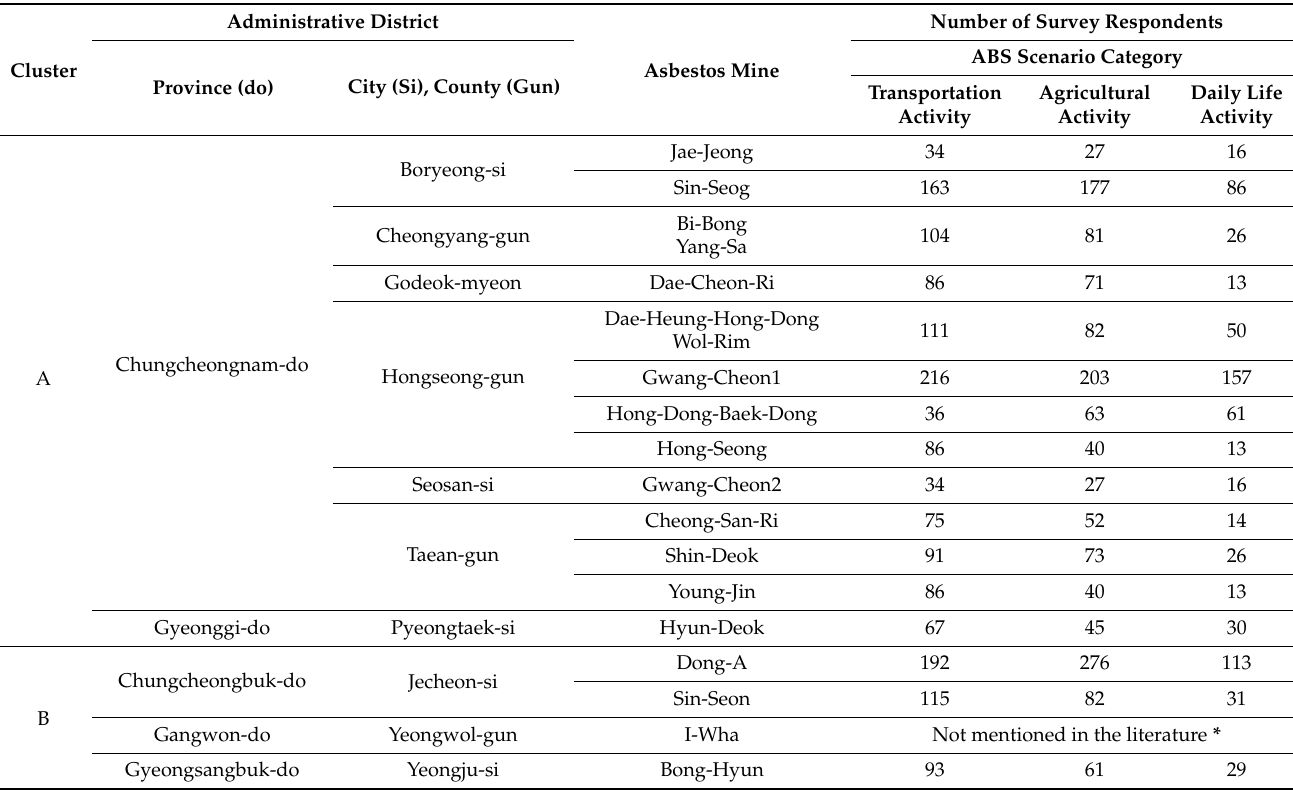
Table 3. Location and number of survey respondents of the abandoned asbestos mines in South Korea.